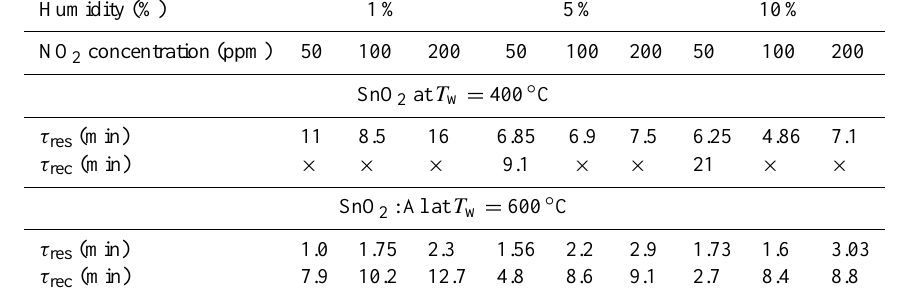
Table 4. Comparison of response and recovery times of SnO 2 and SnO 2 :Al sensing layers towards NO 2 in the presence of 1, 5 and 10% RH. The cells with “ × ” indicate incomplete baseline resistance recovery.